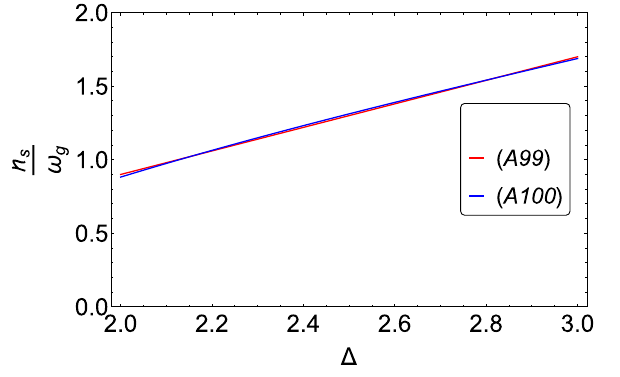
Fig. 23 Solid red curve is a plot of Eq. (A.92) and blue one is a plot of Eq. (A.93) (almost indistinguishable)